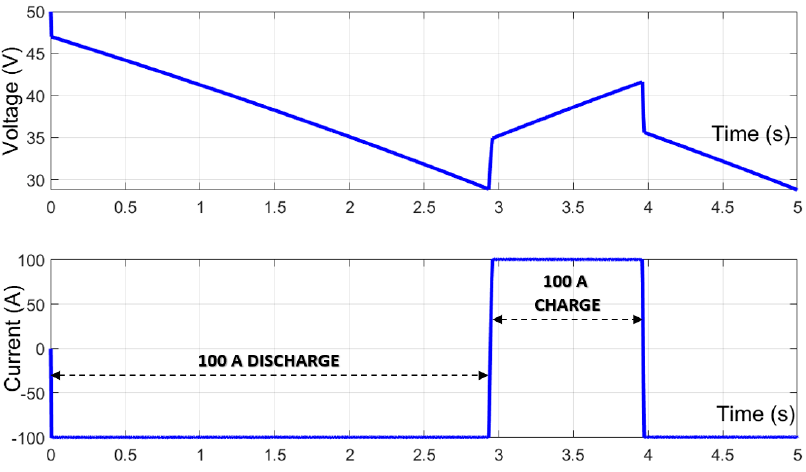
Figure 23. Example of the charge and discharge of the SC array.